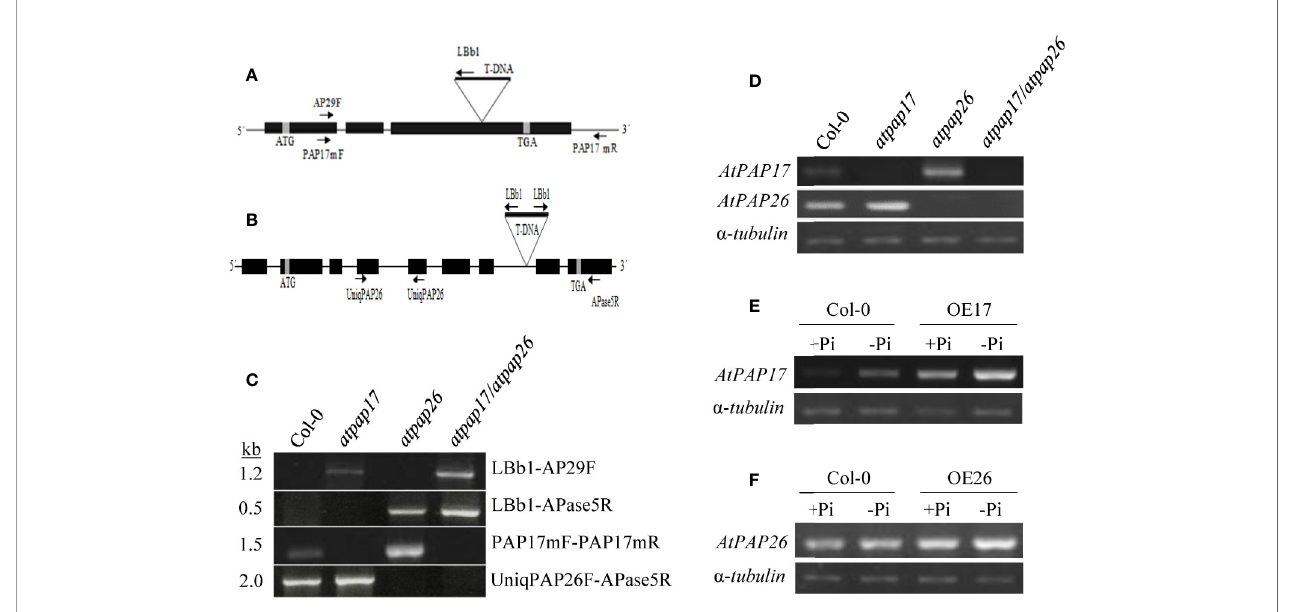
FIGURE 2 | Schematic representation of AtPAP17 (A) and AtPAP26 (B) genes; solid boxes and lines represent exons and introns, respectively. Evaluation and veri fi cation of homozygosity of mutants via PCR-based screening of gDNA using T-DNA left-border and AtPAP17 and AtPAP26 -speci fi c primers (C) . The T-DNA insertion location is indicated by “ triangles-T-DNA, ” and arrows represent primers used for PCR and genotyping. Levels of AtPAP17 and AtPAP26 transcripts were quanti fi ed by semi-qRT-PCR in single and double mutants (D) . Semi-quantitative RT-PCR of AtPAP17 (E) and AtPAP26 (F) expression in homozygous AtPAP17 - and AtPAP26 -overexpressed lines (OE17 and OE26), respectively, grown under +Pi (1.25 mM KH 2 PO 4 ) and − Pi (no Pi) conditions. Also, a -tubulin was used as an internal control for